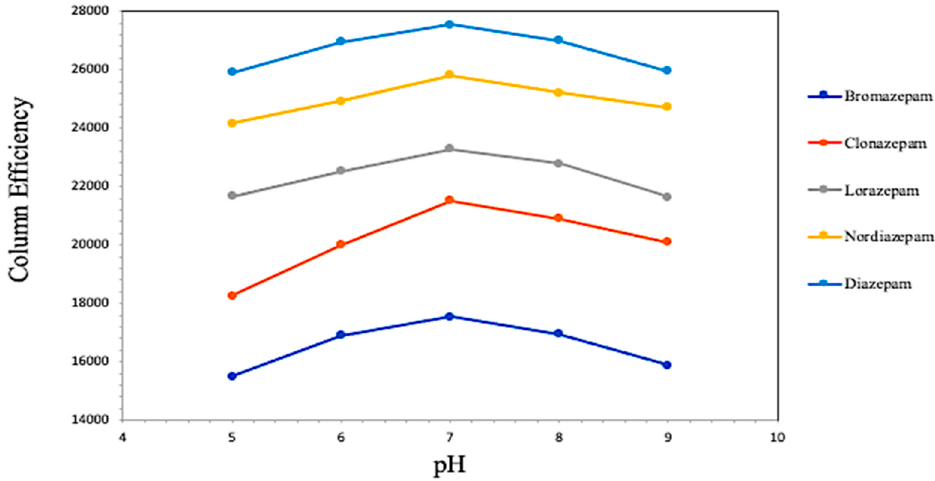
Figure 3. The change of column efficiency of selected BZDs at different pH values of the mobile phase. Other experimental conditions as described in the text.